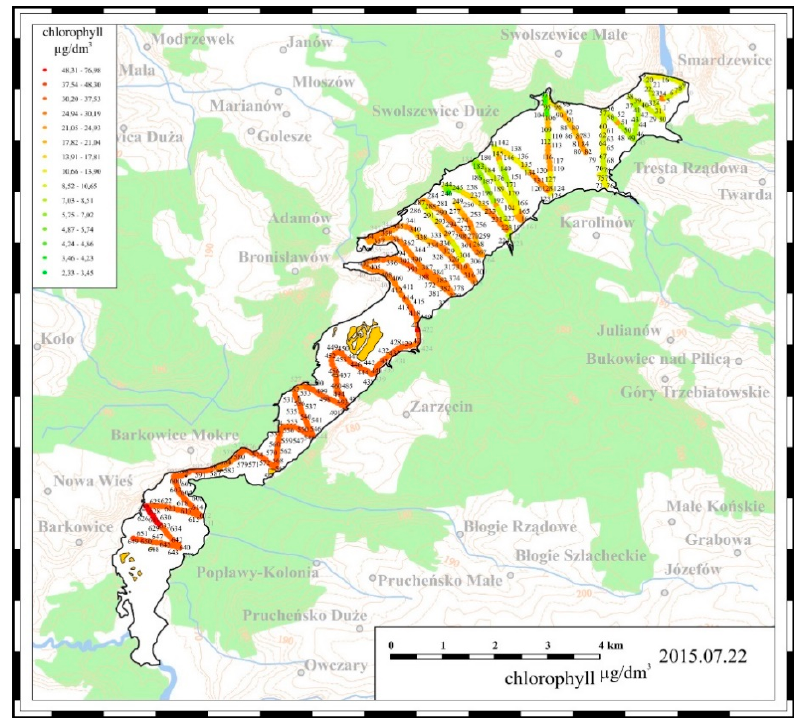
Figure 3. Profile of changes in chlorophyll concentration ( μ g/dm 3 ) in the area of the Sulejow Reservoir, obtained with a mobile measurement system on 19 July 2016.